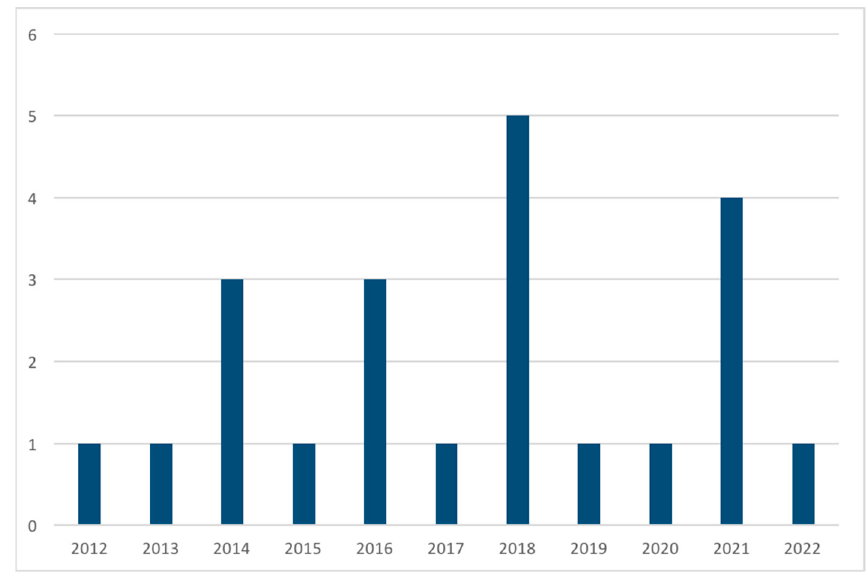
Figure 2. Number of articles by